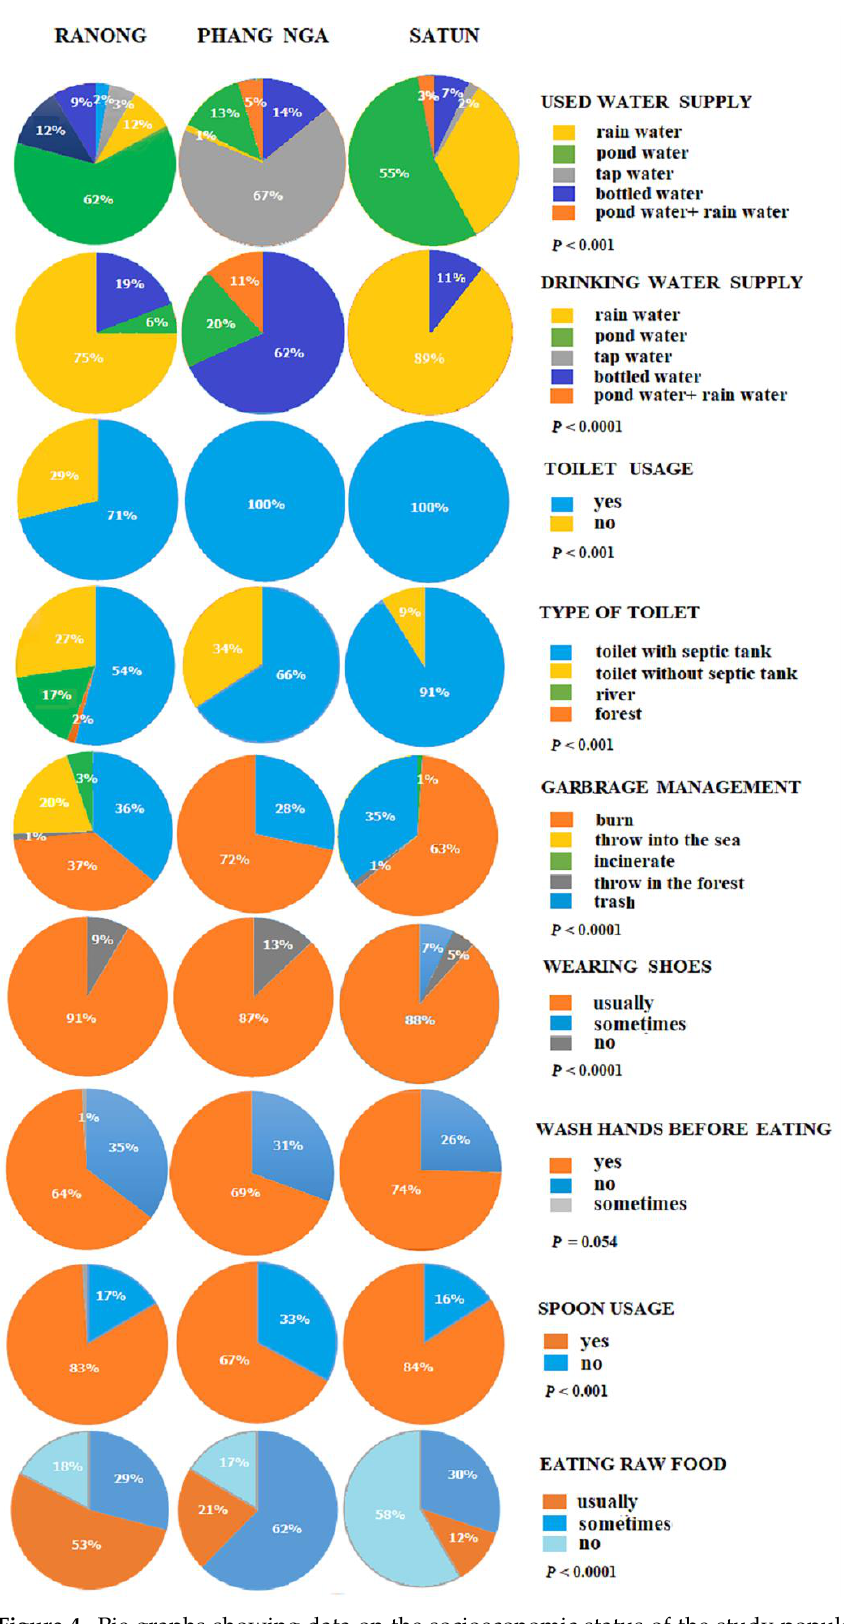
Figure 4. Pie graphs showing data on the socioeconomic status of the study population, i.e., the Moken from Ranong, the Moken from Phang Nga, and the Orang Laut from Satun